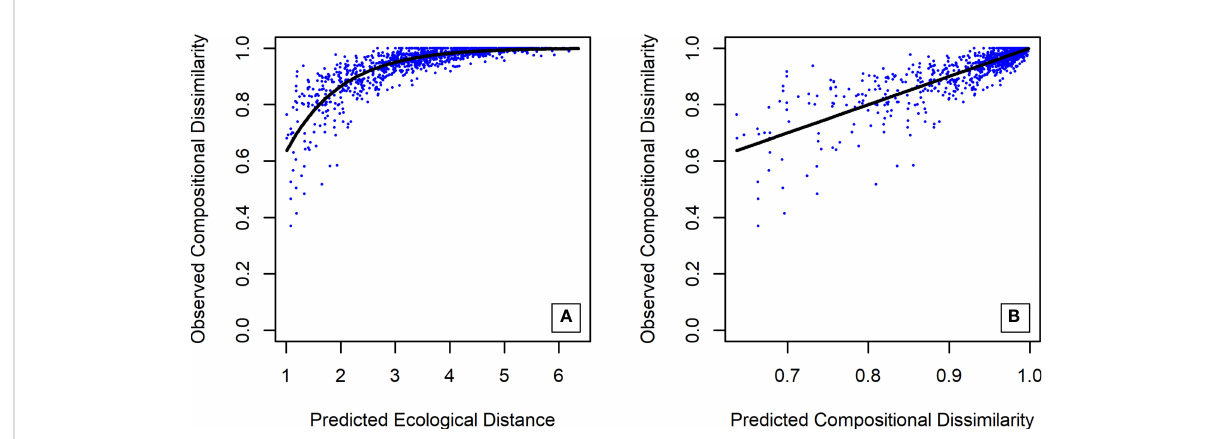
FIGURE 5 Diagnostic plots from generalized dissimilarity modeling (GDM) of observed compositional dissimilarity against predicted ecological distance (A) and predicted compositional dissimilarity (B) .